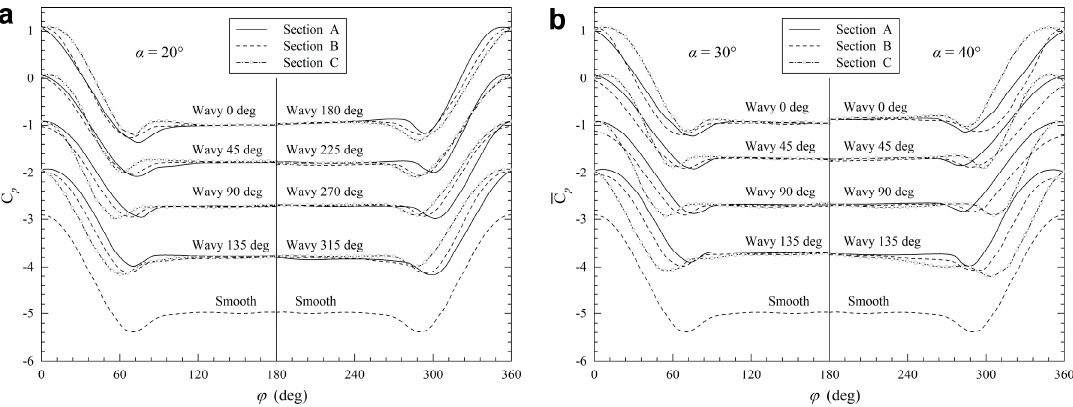
Figure 11. Average circumferential pressure coefficient distributions of ( a ) the wavy cylinder A1 and ( b ) the wavy cylinders A2 and A3.